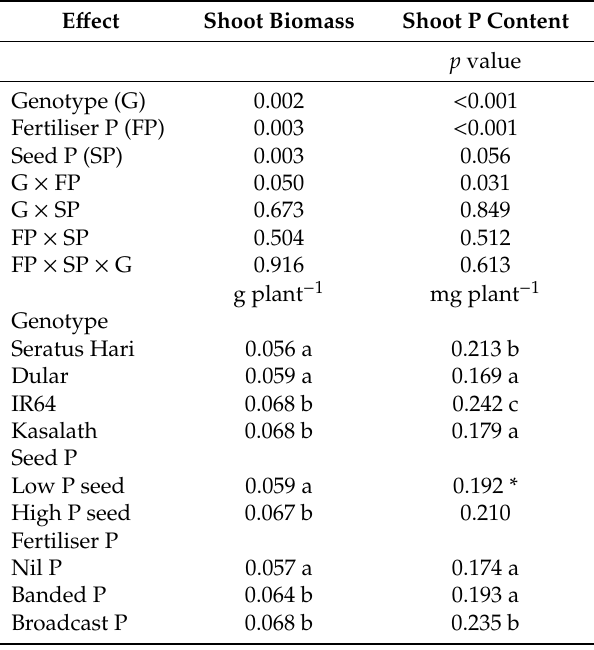
Table 4. ANOVA results for shoot biomass and shoot P content in Experiment 2 (Ferralsol). Treatments that share a common letter within a column in the main e ff ect of “seed P” are not significantly di ff erent at p ≤ 0.05. E ff ect Shoot Biomass Shoot P Content p